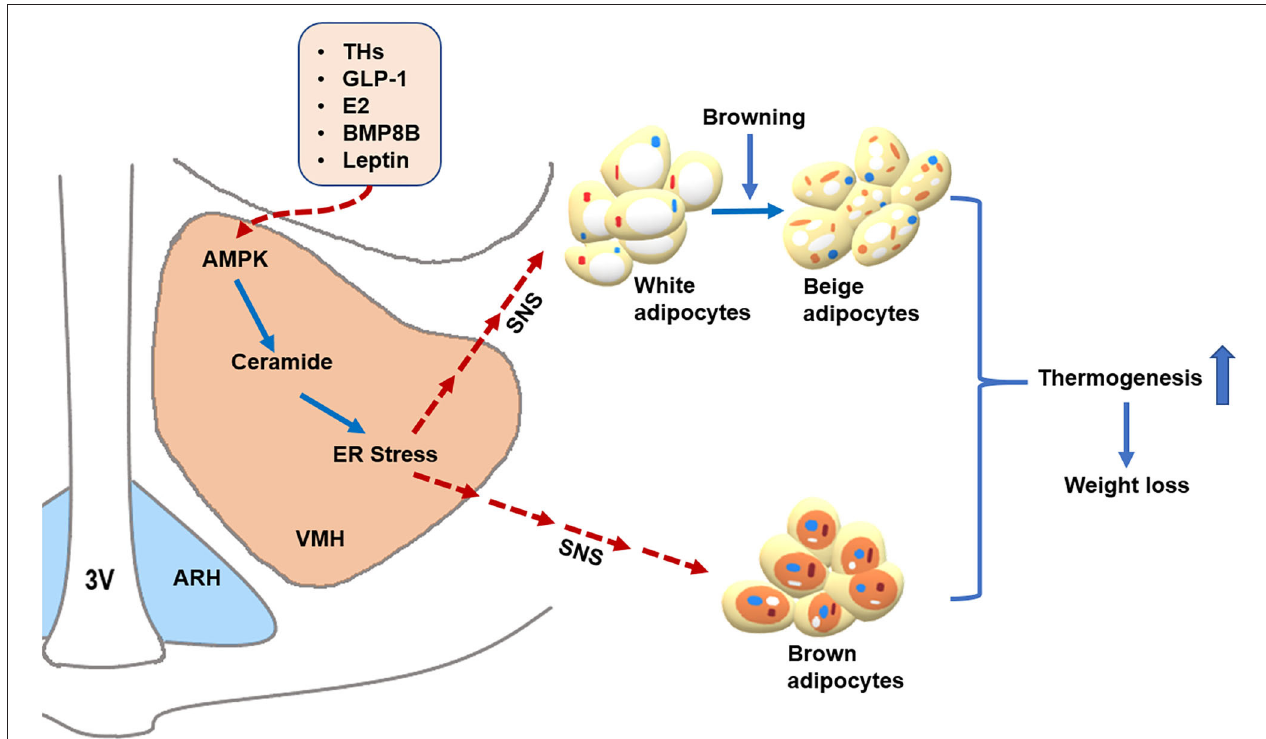
FIGURE 1 | AMPK within the VMH regulates BAT thermogenesis and WAT browning. Peripheral signals, such as THs, GLP-1, E2, BMP8B, and leptin, may act on the VMH to inhibit AMPK, which subsequently promotes BAT thermogenesis and WAT browning through activating the SNS, resulting in body weight loss. Additionally, THs and E2 may decrease ceramide and ER stress levels by suppressing AMPK in the VMH, leading to enhanced thermogenesis via the SNS. Alleviating ER stress in the VMH also increases hypothalamic leptin sensitivity. Whether ceramide and ER stress can mediate the thermogenic effects of GLP-1 and BMP8B warrant further investigation. The solid blue arrows represent activation, the dotted red arrows represent inhibition. 3V: third ventricle. ARH: arcuate nucleus of the hypothalamus. VMH: ventromedial nucleus of the hypothalamus. AMPK: adenosine monophosphate-activated protein kinase. ER stress: endoplasmic reticulum stress. SNS: sympathetic nervous system. THs: thyroid hormones. GLP-1: glucagon-like peptide-1. E2: estrogens. BMP8B: Bone morphogenetic protein